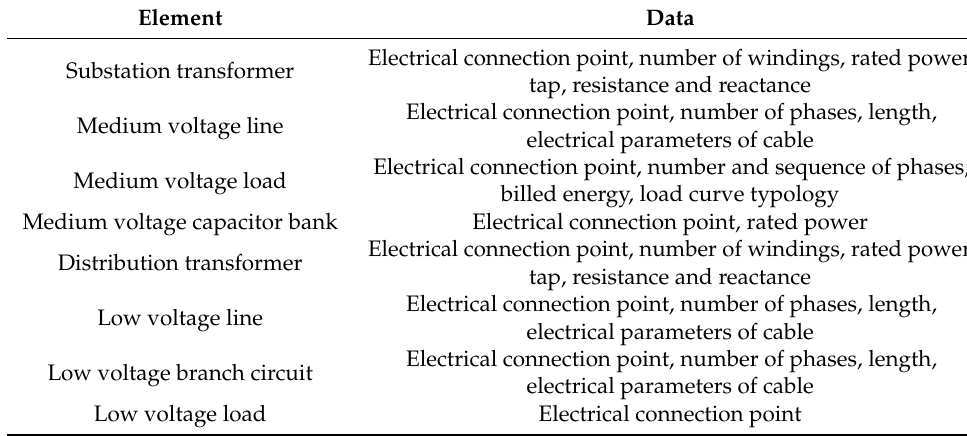
Table 1. Electric network modeling using BDGD data.